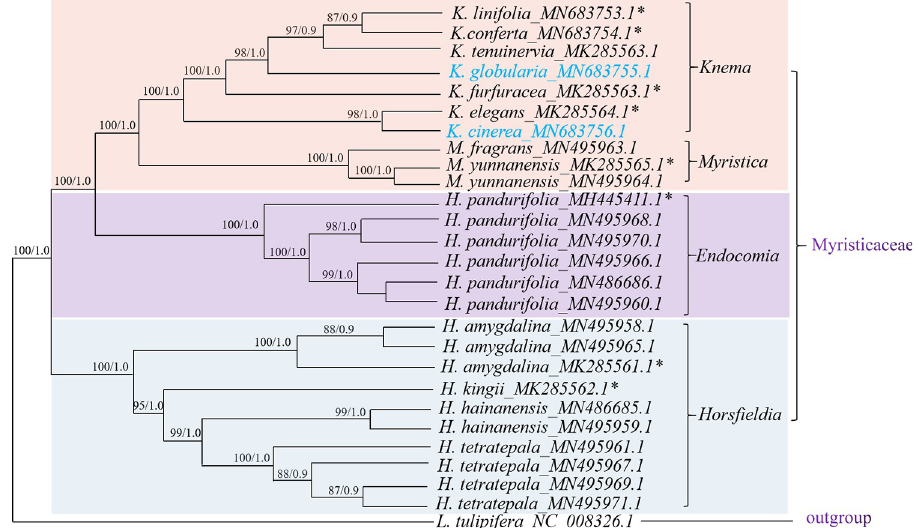
Fig 8. The phylogenetic tree based on complete chloroplast genome sequences of Myristicaceae with ML and BI method. Support values are bootstrap values ( > 50%, before slash) and posterior probability ( > 0.5, after slash), respectively. The species with blue font indicates the two newly sequenced in this study; “ � ” indicates that the data were derived from the authors.